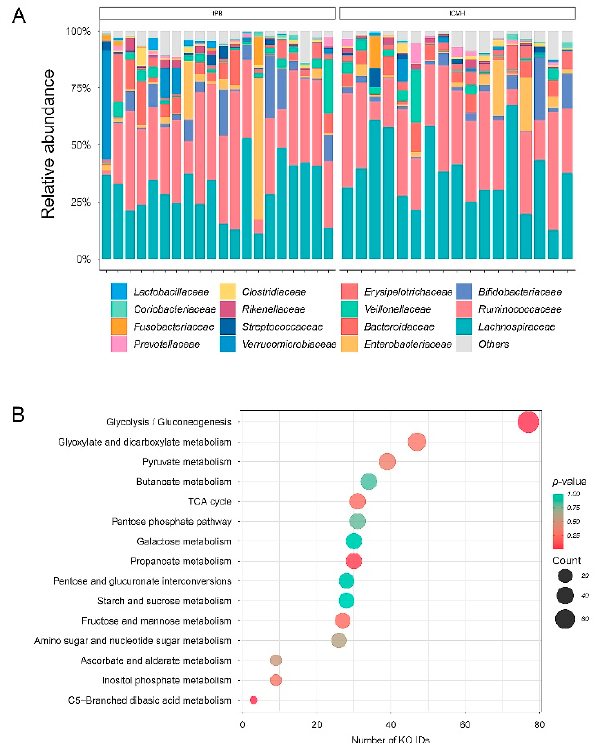
Figure 1. Microbial composition and metabolic function after treatment with CMH, using 16S rRNA gene sequences datasets. ( A ) Microbial composition changes at family level. ( B ) Top 15 associated pathways in carbohydrate metabolism. Note: tPB and tCMH represent treatment with placebo and CMH, respectively.